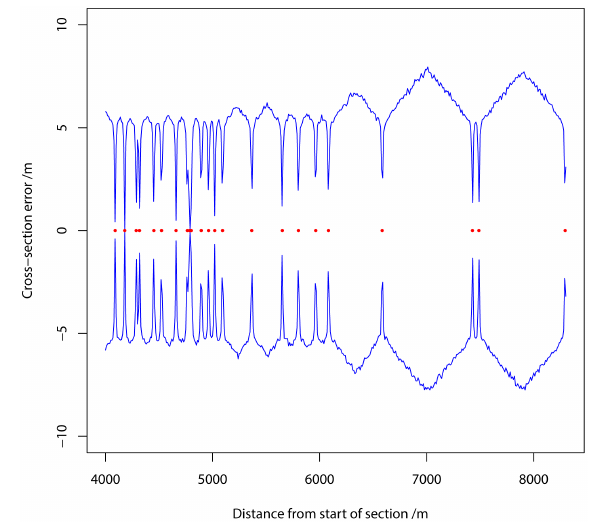
Figure 2. All validation observations of the interpreted and ob- served height of the base of the London Clay AOD. The red line is the bisector.